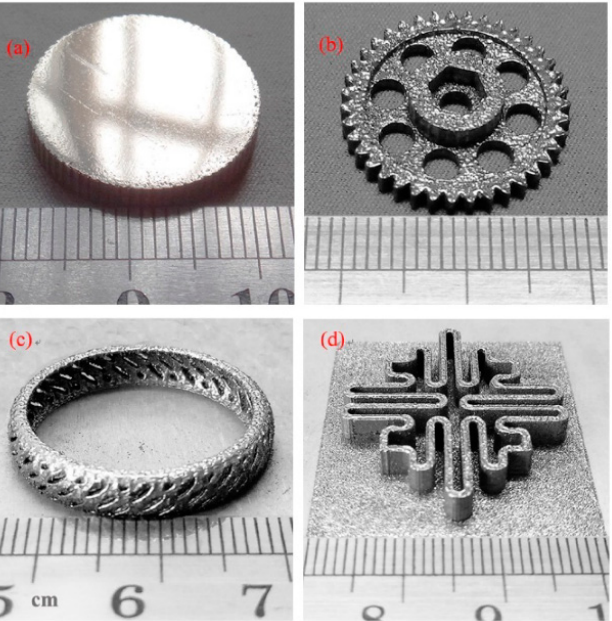
Figure 17. Cu-based BMG parts with different geometries fabricated via LPBF. Reproduced from [52], with permission from Elsevier, 2021.